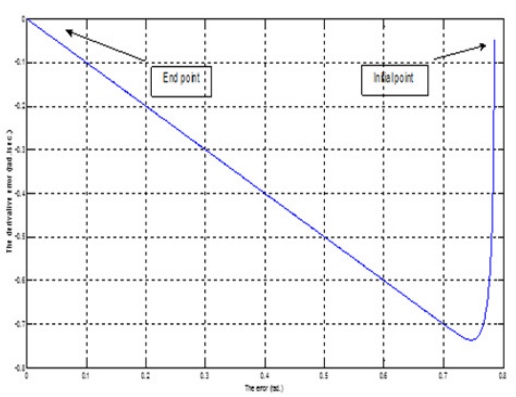
Fig. 12. The error _ vs. time of the CSMC ‘